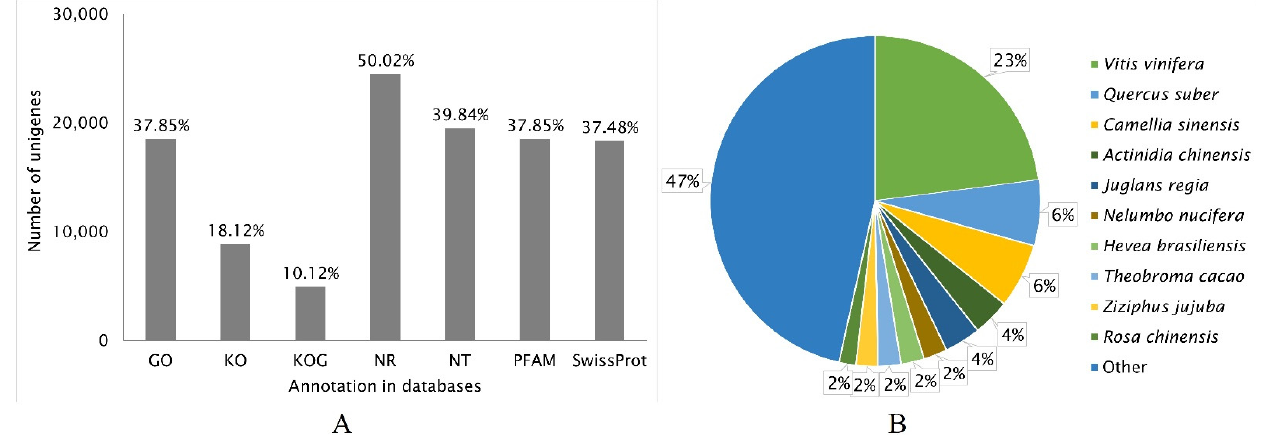
Figure 2. Number of unigenes of blackcurrant cv. Aldoniai annotated into different databases ( A ) and the identity (round value) of plant species to R. nigrum gene annotation according to the NR database ( B ). The functions of R. nigrum unigenes were annotated using GO, KEGG, and